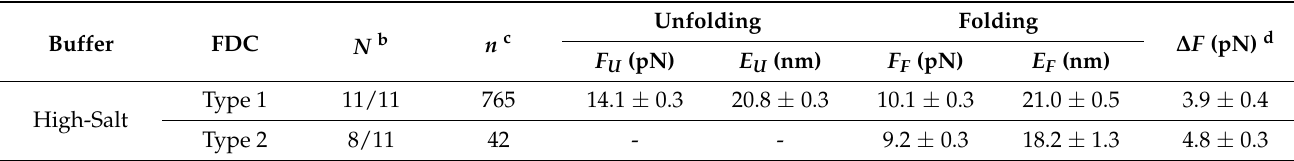
Table 1. Force ( F ), extension ( E ), and force difference ( ∆ F ) for the WT pre-miRNA-377 unfolding and folding determined by optical tweezers in different buffers a . Buffer